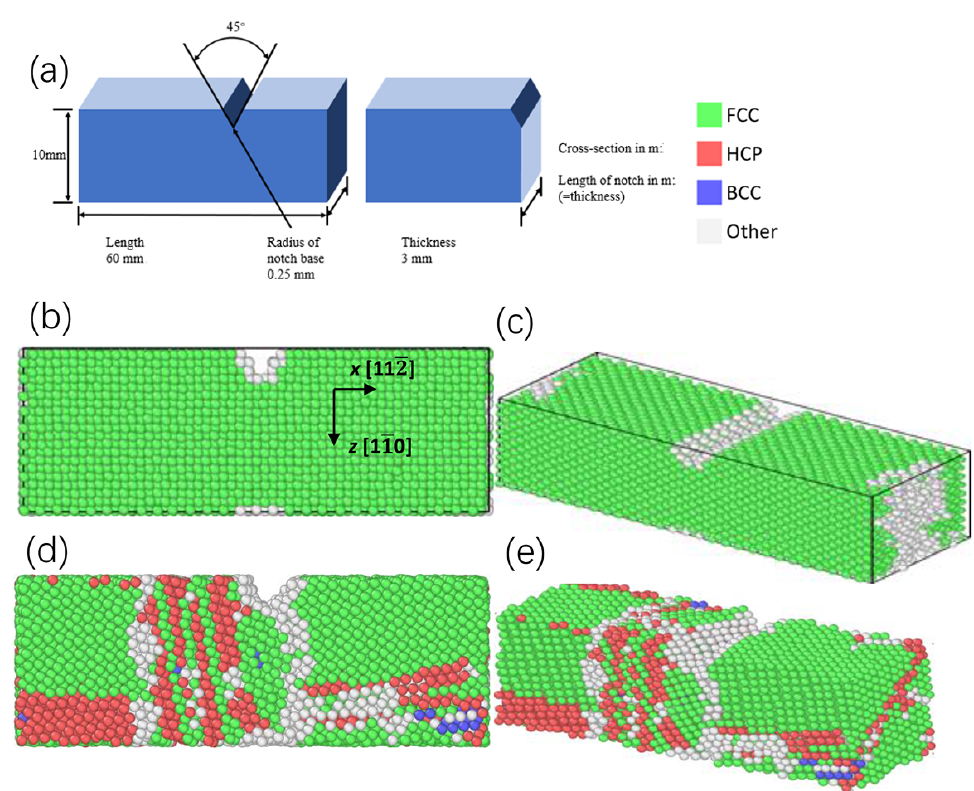
Figure 1. Model for a pre-crack in Al 0.1 CoCrFeNi HEA—single crystal and grain boundary versions: ( a ) sketch map of pre-crack for SC-HEA; ( b , c ) the SC-HEA model; ( d , e ) the GB-HEA model.